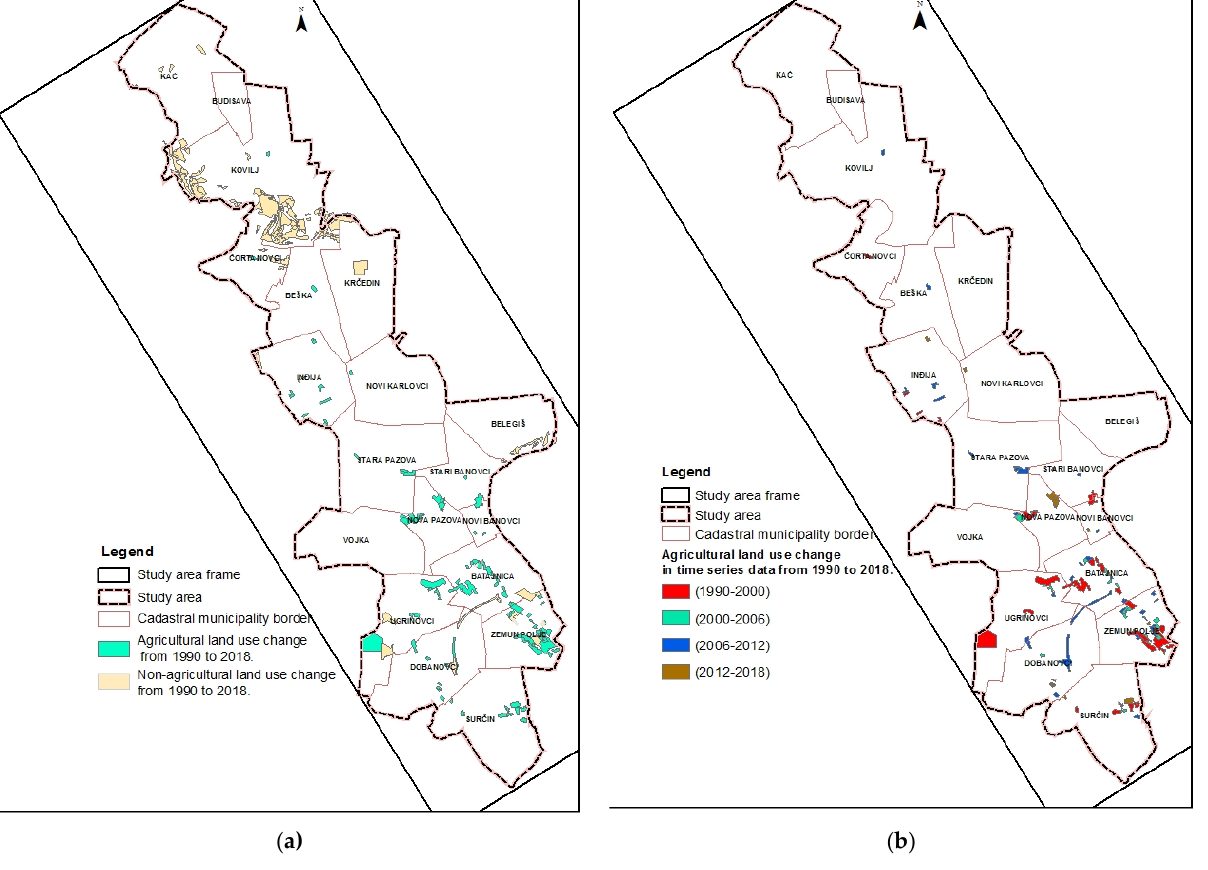
Figure 4. ( a ) Agricultural land-use change to other land uses in the period between 1990 and 2018; ( b ) dynamics of agricultural land-use change in the time series data of 1990–2000–2006–2012–2018. Data from Figure 4b is presented in the table showcasing the dynamics of agricultural land-use change through different time series (Table 1). Table 1. Agricultural land-use change in artificial land-use in times series from 1990 to 2018 (in ha).